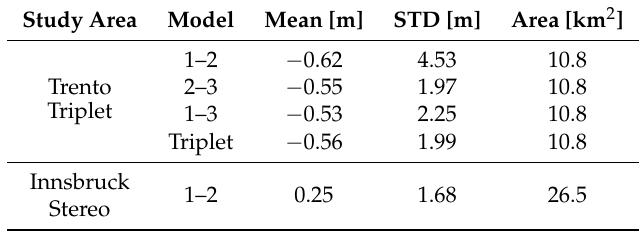
Table 11. Statistics of height differences between LiDAR and Pléiades DSMs on non-forest